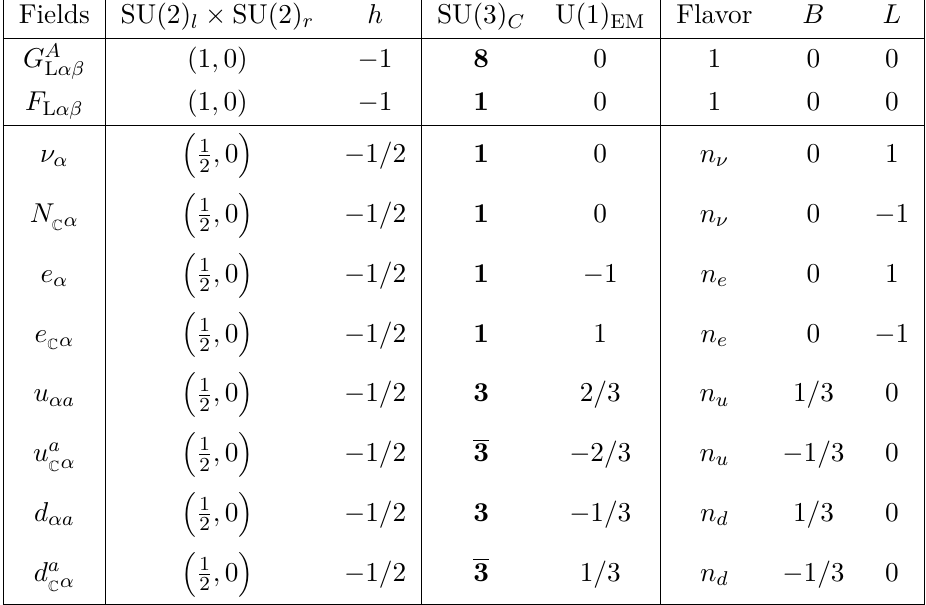
Table 2 . The field content of the ν LEFT. The numbers of neutrino flavors, electron flavors, u-type quark flavors and d-type quark flavors are denoted as n n e = 3 , n u = 2 and n d = 3 in ν